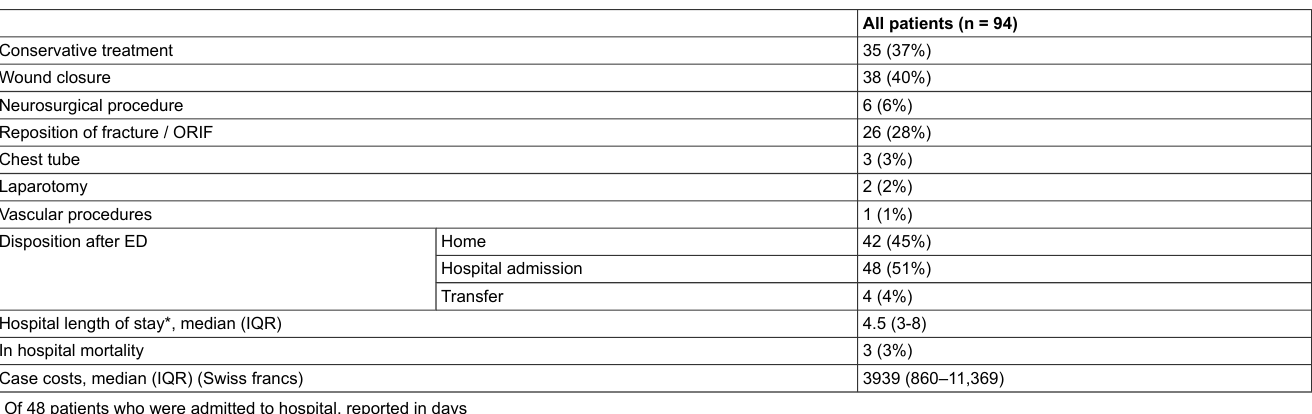
All patients (n = 94)